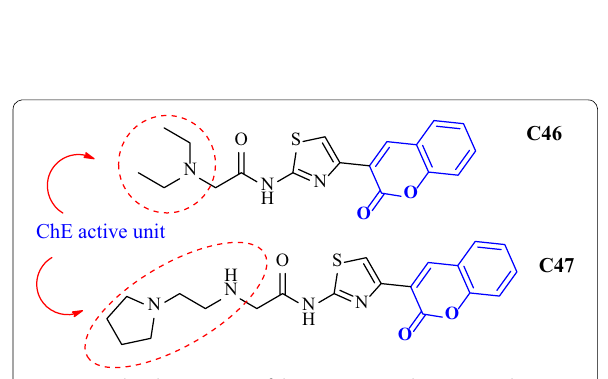
Fig. 50 Molecular structure of the most anti-AChE ( C46 ) and anti-BuChE ( C47 ) thiourea